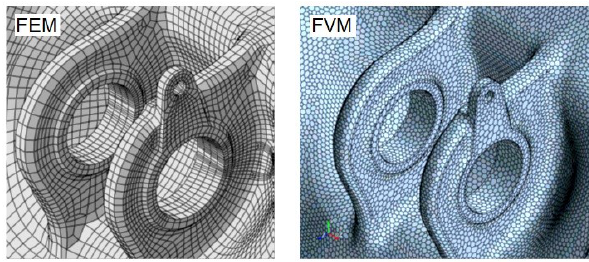
Figure 4: Fragments of Discrete Models